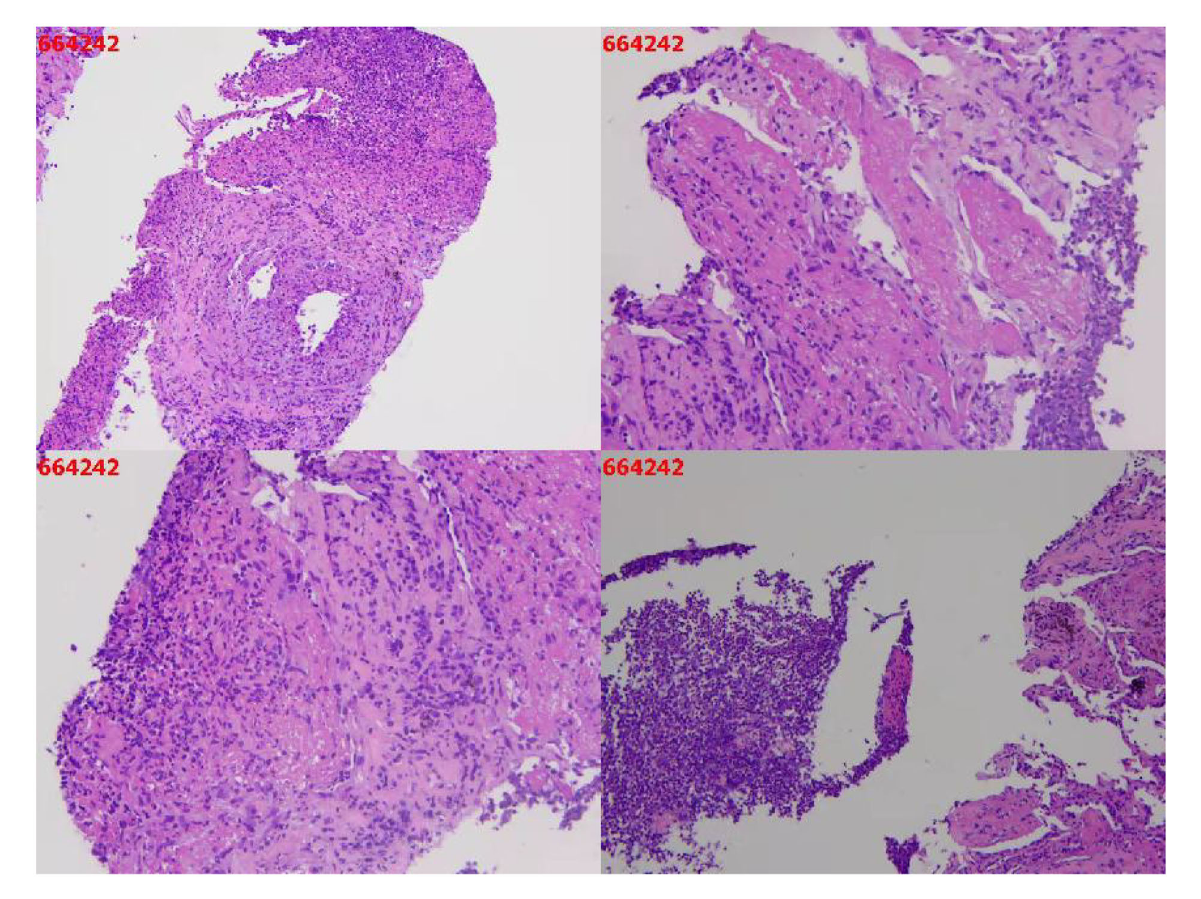
FIGURE3 Histopathological results of the